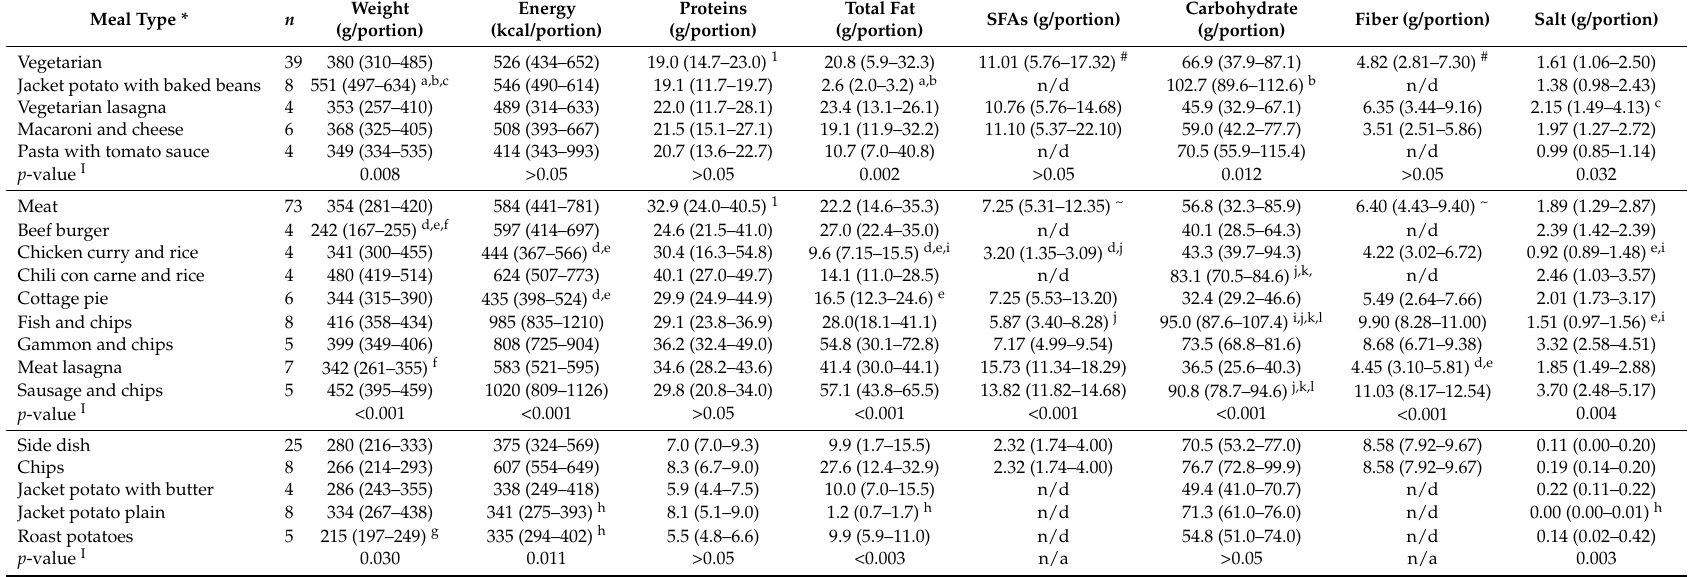
Table 2. Nutritional composition of meals served in hospitals staff canteens per